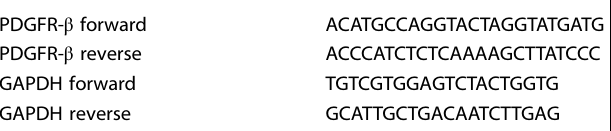
Table 1. The primer sequences selected for qRT ‒ PCR PDGFR- β forward